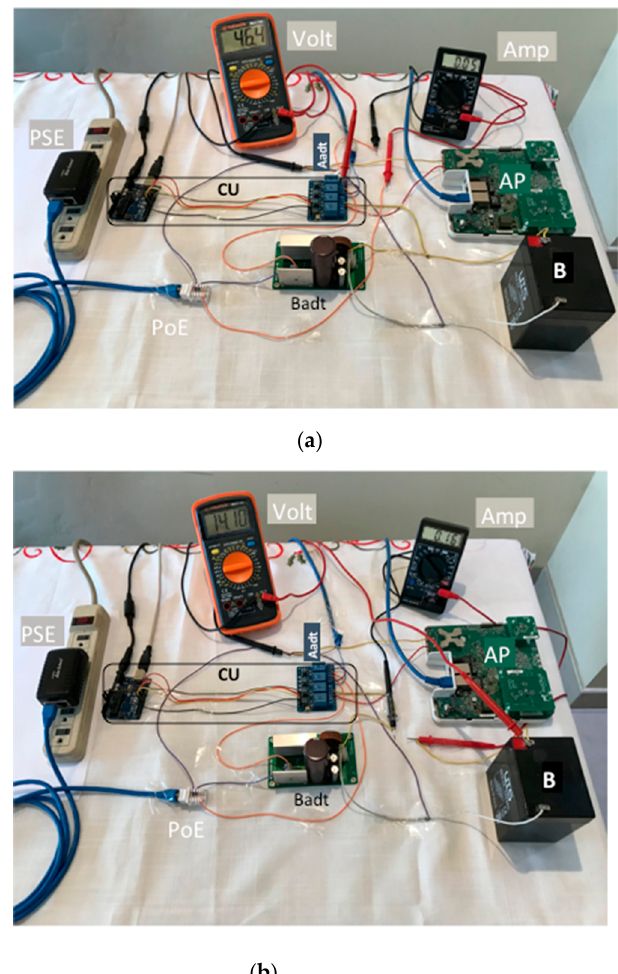
Figure 8. Charging current and voltage of the B with our mechanism: ( a ) the power-over-ethernet (PoE) output, ( b ) the Badt output.